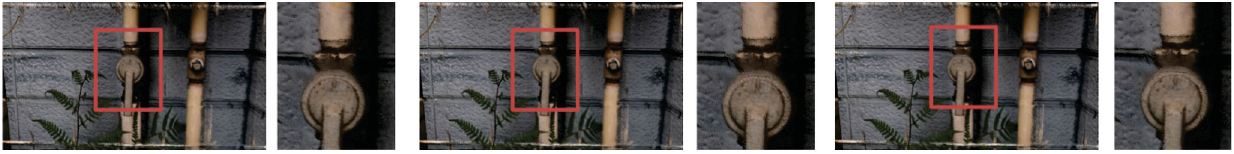
Fig. 8 Background restoration for consecutive frames of Scene 1.